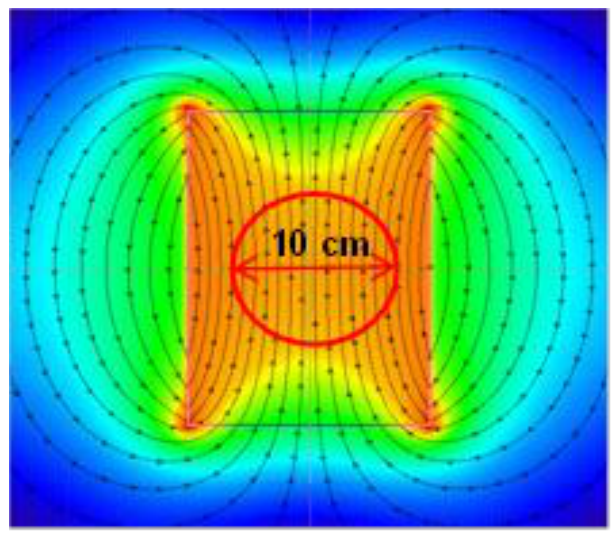
Figure 2. Distribution of variable magnetic field, induction of B = 100 mT and frequency of f = 50 Hz, within the sample subjected to extraction.